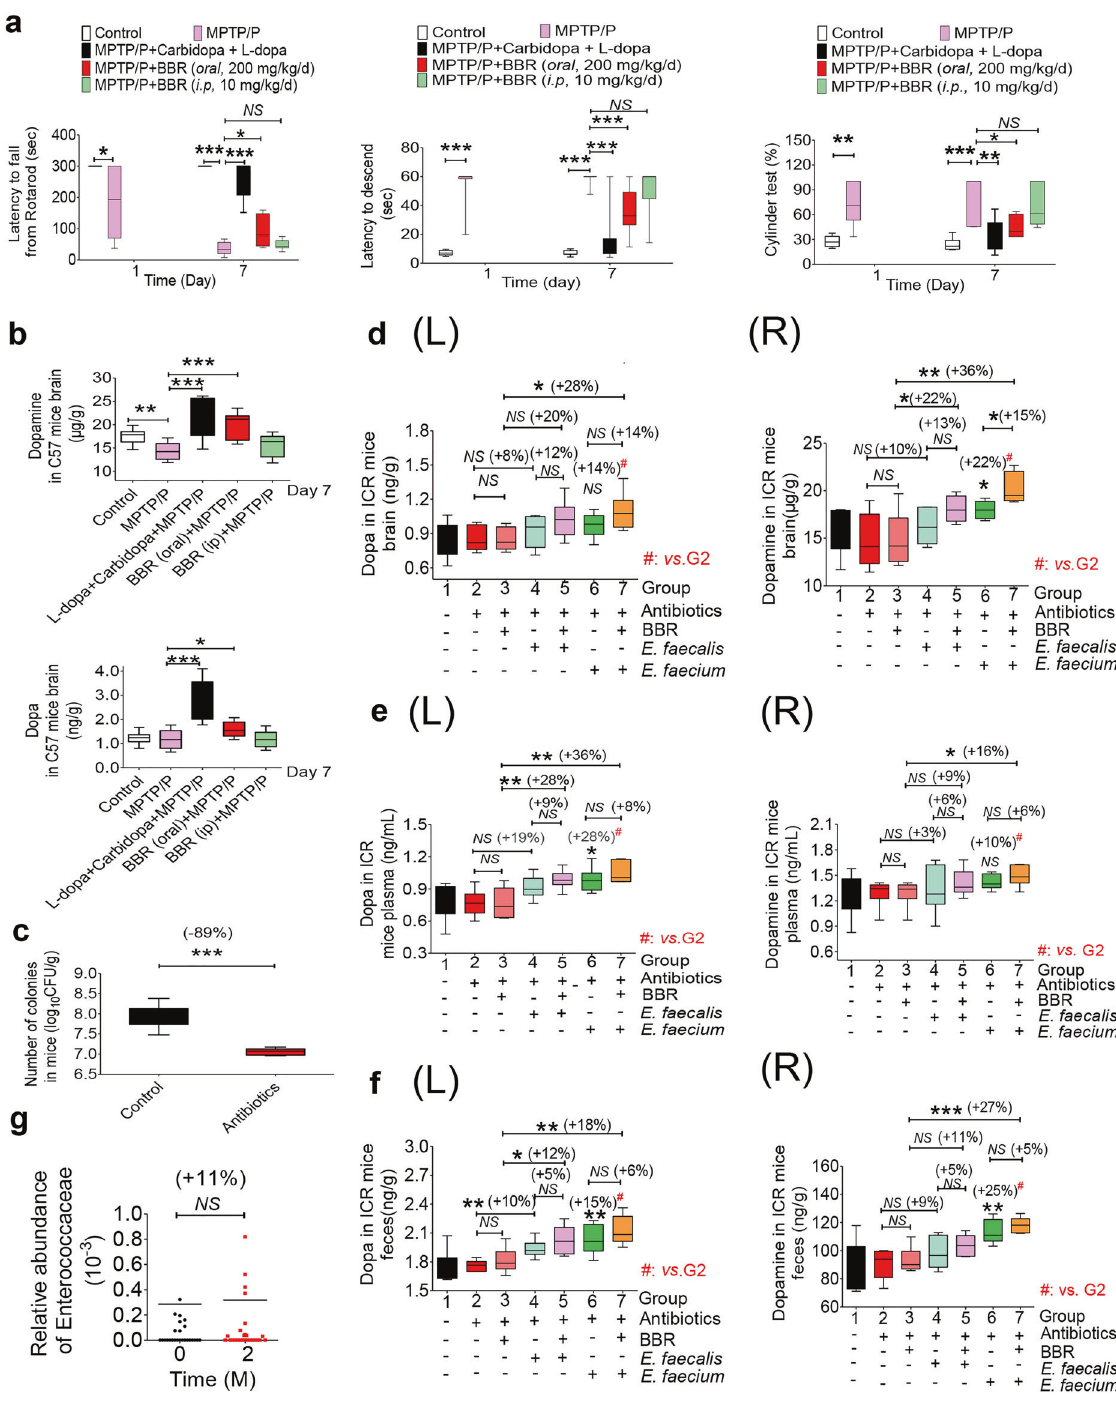
Fig. 5 E . faecalis and E . faecium regulated dopa/dopamine and improved brain function in PD animals in the presence of BBR. a Treating mice with both MPTP (20 mg/kg/d, s.c.) and P (200 mg/kg/d, i.p.) for 7 days successfully generated the damage to brain function (LD, *** P < 0.001; LFR, *** P < 0.001) in the model mice. Carbidopa (1 mg/kg, s.c.) in combination with L -dopa (10 mg/kg/d, s.c.) for 6 days (from days 2 to 7) decreased the LD, cylinder test value (*** P < 0.001, ** P < 0.01), and increased the LFR (*** P < 0.001); BBR (200 mg/kg/d, orally, days 2 to 7) signi fi cantly reduced the LD, cylinder test value (*** P < 0.001, * P < 0.05), and elevated the LFR (* P < 0.05). Intravenous injection of BBR (10 mg/ kg, for 6 days) did not cause a signi fi cant change in the LD, LFR, or cylinder test. b Levels of dopa/dopamine in the brain on day 7 of the experiment (mean ± SD, * P < 0.05 for dopa; ** P < 0.01, *** P < 0.001 for dopamine). c Number of colonies from the mice treated with the antibiotics was signi fi cantly lower than that from the normal mice (mean ± SD, *** P < 0.001). d – f Translation of E. faecalis and E. faecium into the mice treated with antibiotics signi fi cantly increased dopa (L)/dopamine (R) levels in ICR mouse brains ( d , * P < 0.05, ** P < 0.01, NS no signi fi cance), blood ( e , * P < 0.05, ** P < 0.01), and feces ( f , (L), (R), * P < 0.05, ** P < 0.01, *** P < 0.001). g The relative abundance of Enterococcaeae in the fecal samples of clinical subjects increased after the two-month BBR treatment. Data are represented as the mean ±